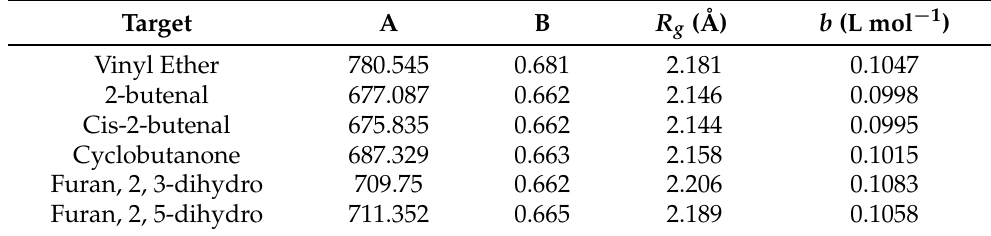
Figure 10. The correlation plot of Q tot ( E i ) with A ( E i ) − B for vinyl ether and its isomers. Solid star: present Q tot data points; solid line: analytical fitting function A ( E i ) − B . Table 2. The fitting parameters of Equation (8). Gas-kinetic radius ( R g ) and van der Waals coefficient ( b ) of the present